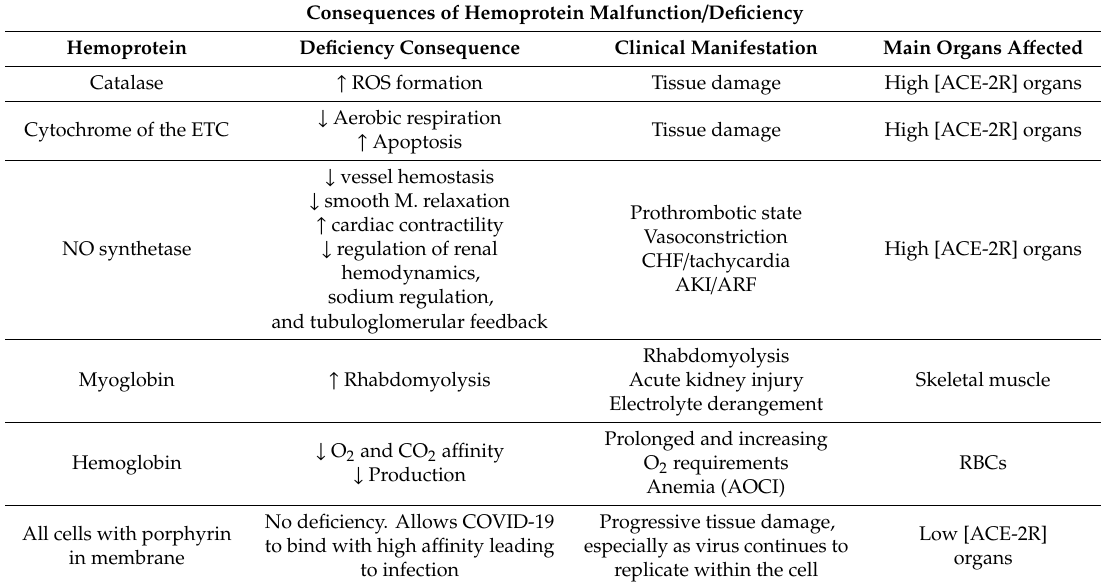
Table1. Thisrepresentsalistoffunctionalhemoproteinsandtheclinicalscenarioscausedbydysfunction of these hemoproteins. Key: AKI = acute kidney injury, ARF = acute renal failure, CHF = congestive heart failure, AOCI = anemia of chronic